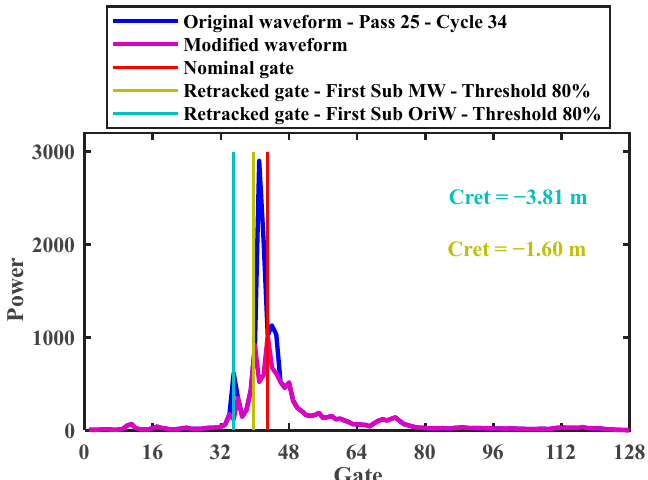
Figure 12. Retracking of the first sub-waveform of the original and modified waveform of pass 25 and cycle 34 over the Persian Gulf.